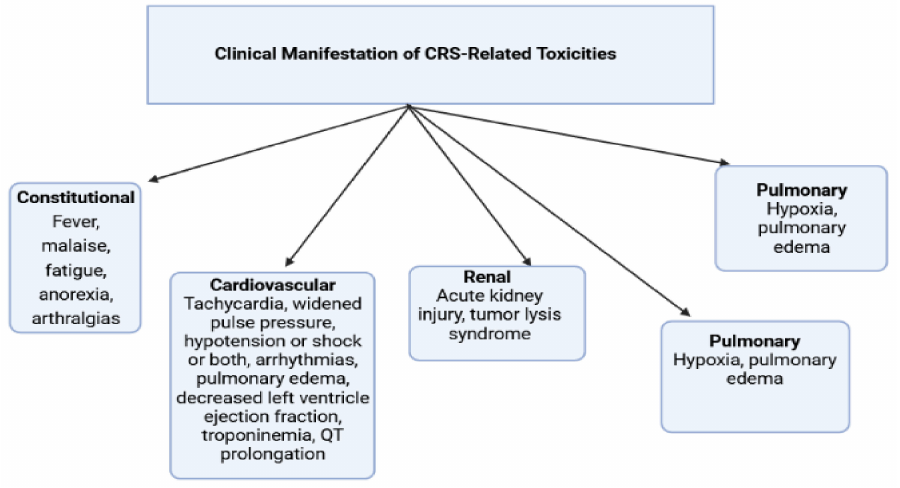
Figure 4. Clinical manifestation of CRS-related